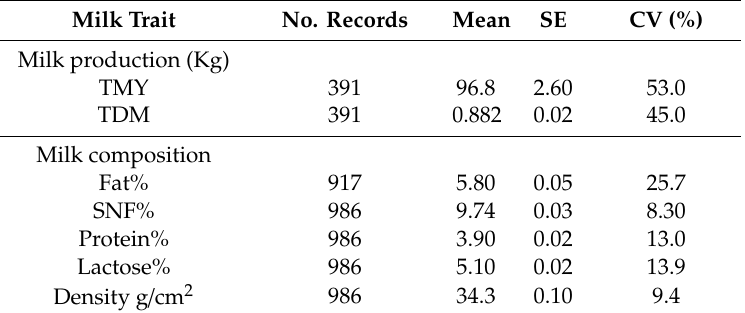
Table 2. Descriptive statistics of milk production and milk composition traits.